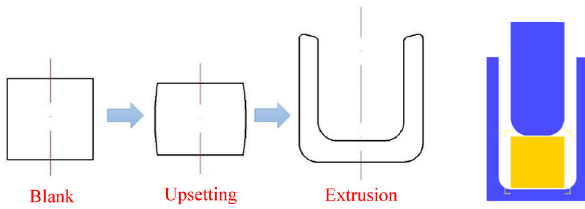
Figure 7: Schematic diagram of cold extrusion process and its FEM model.